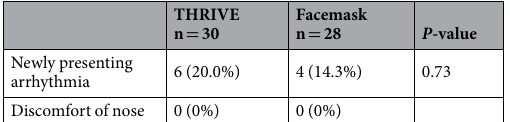
Table 4. Newly Presenting Arrhythmia and Discomfort of Nose. Data are given as n (%). Abbreviations: THRIVE, transnasal humidified rapid insufflation ventilator